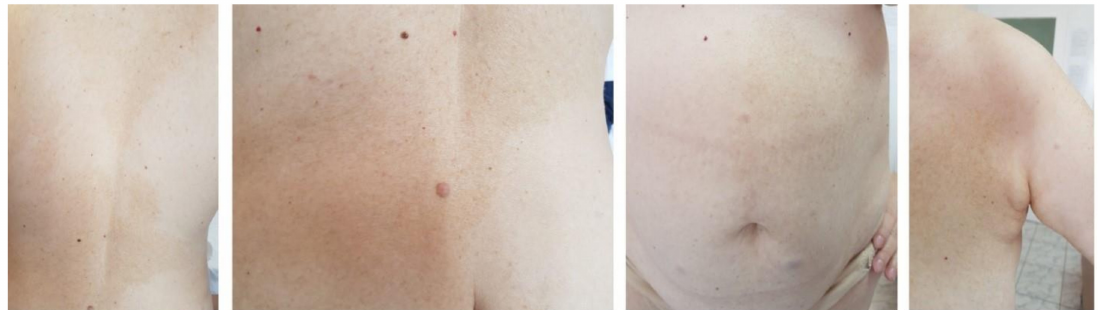
Figure 2. Large, poorly circumscribed areas of cutaneous hyperpigmentation and freckling on the trunk (scale 1:13 / 1:6 / 1:13 / 1:13).